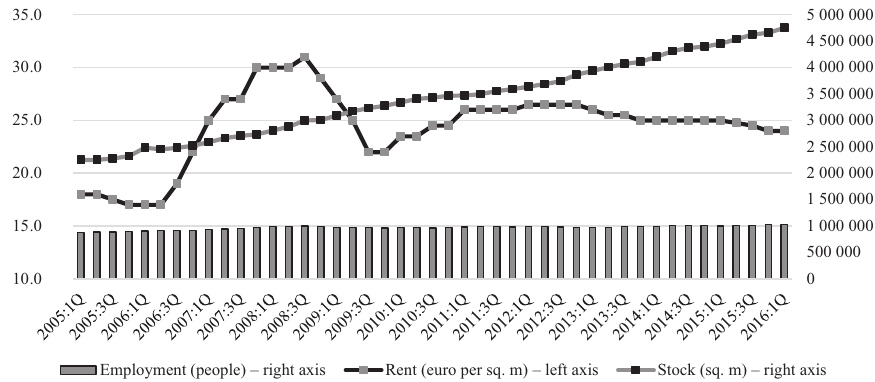
Figure 1. Dynamics of rent, stock and employment in Warsaw, 2005:1Q–2016:1Q (source: own study)